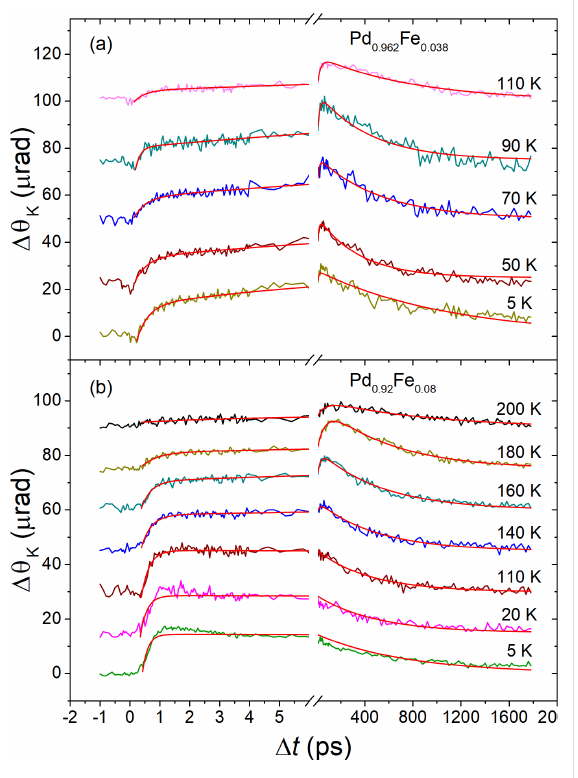
Figure 2: Temperature evolution of the time-resolved magneto-optical Kerr angle transients for the Pd 0.962 Fe 0.038 (a) and Pd 0.92 Fe 0.08 (b) epitaxial thin films at T < T C ; red solid lines are the results of fits with Equation